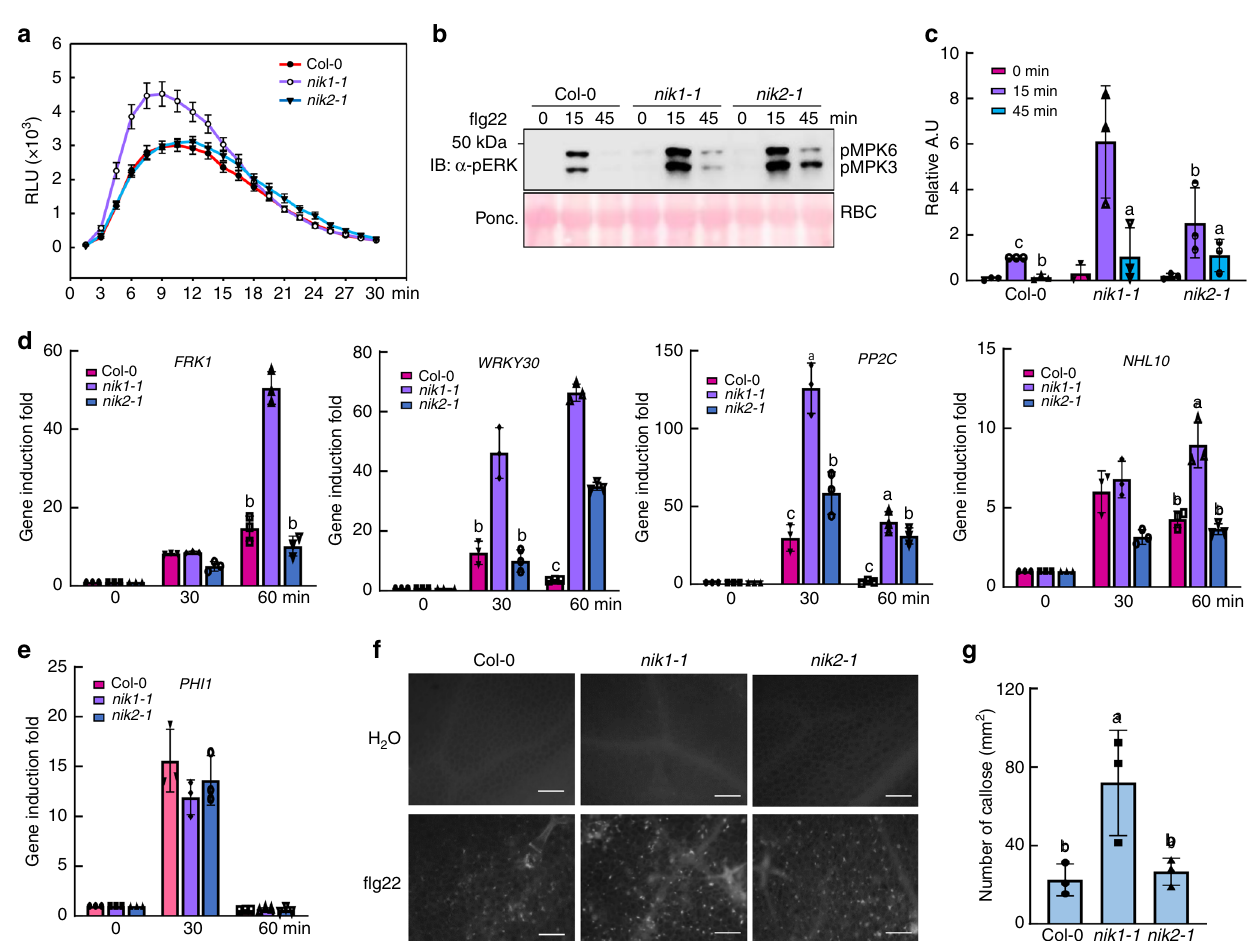
Fig. 2 Elevated PTI early responses in nik1-1- null mutants. a Flg22-induced ROS burst in WT, nik1-1 and nik2-1 plants. Leaf discs from 5-week-old plants were treated with water or 500 nM fl g22 for 30 min, and the relative light units (RLU) were detected. Values represent the mean ± SE ( n > 10). b Flg22-induced MAPK activation in WT, nik1-1 and nik2-1 plants. Ten-day-old seedlings from the Col-0-, nik1-1 - and nik2-1- knockout lines were treated with 100 nM fl g22 and harvested at 0, 15 and 45 min post treatment. MAPK activation was monitored by immunoblotting total protein extracts with an α -pERK antibody (top panel). Protein loading was evaluated by Ponceau S staining for Rubisco (RBC) (bottom panel). c Quantitative data for MAPK activity signals. ImageJ was used to quantify signal intensity. Different letters denote signi fi cant differences by the one-way ANOVA test ( n = 4, p < 0.05). d Relative induction of the PTI-associated marker genes FRK1 , WRKY30 , PP2C and NHL10 . Ten-day-old seedlings were treated with 100 nM fl g22 for 30 and 60 min. Total RNA was extracted for qRT-PCR analysis. Values represent the mean ± SD of fi ve biological replicates. Different letters denote signi fi cant differences by the one-way ANOVA test ( p < 0.05). e Gene induction of the CPK pathway-speci fi c marker gene PHI1 upon fl g22 treatment. f Flg22-induced callose deposition in WT, nik1-1 and nik2-1 plants. Leaves of 5-week-old plants were in fi ltrated with 500 nM fl g22 for 12 h and callose was detected by aniline blue staining. g